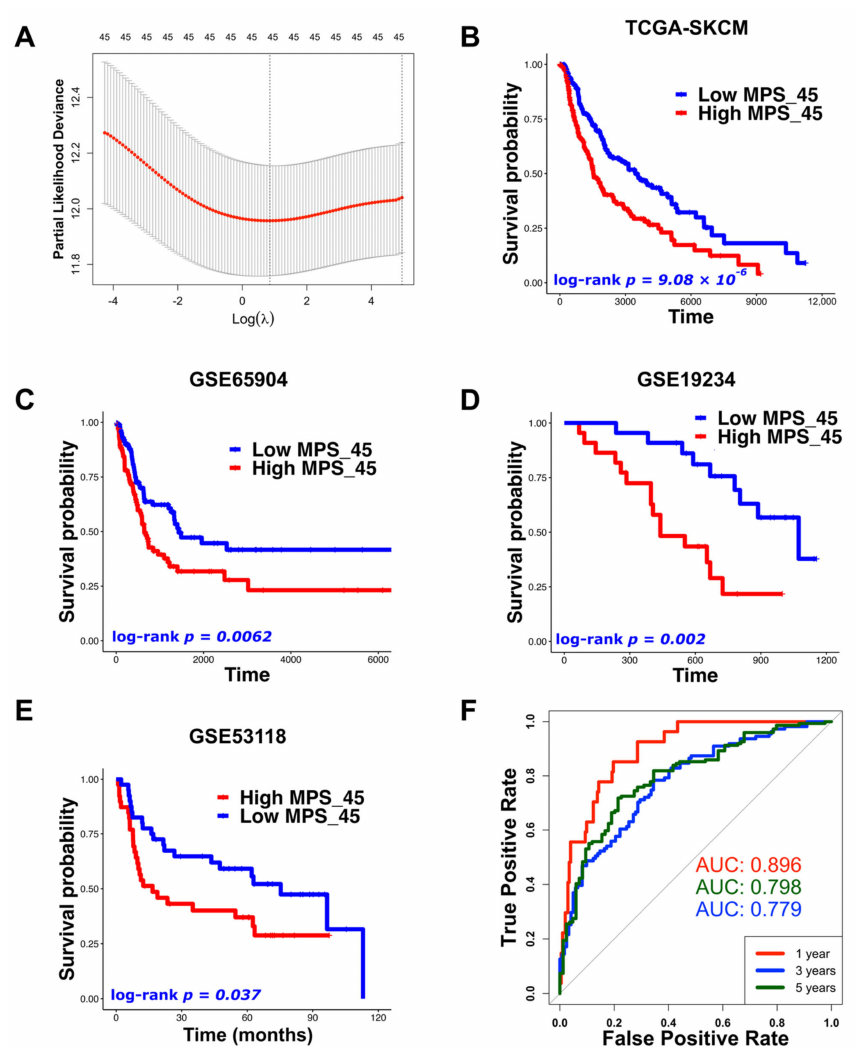
Figure 8. The prognostic signature (MPS_45) was significantly correlated with overall survival in TCGA-SKCM patients and external melanoma GEO datasets. ( A ) Ridge regression Cox analysis for the 45 DEGs of the “Ribosomal biogenesis” GES (alpha = 0). ( B – E ) Kaplan–Meier survival curves comparing high and low MPS_45 groups in ( B ) TCGA-SKCM ( p = 9.08 × 10 − 6 ), ( C ) GSE65904 ( p = 0.006), ( D ) GSE19234 ( p = 0.002), and ( E ) GSE53118 ( p = 0.037) datasets. ( F ) Time-dependent ROC curves of the MPS_45 using TCGA-SKCM samples for overall survival at 1, 3, and 5 years (AUC = 0.896, 0.779, and 0.798,